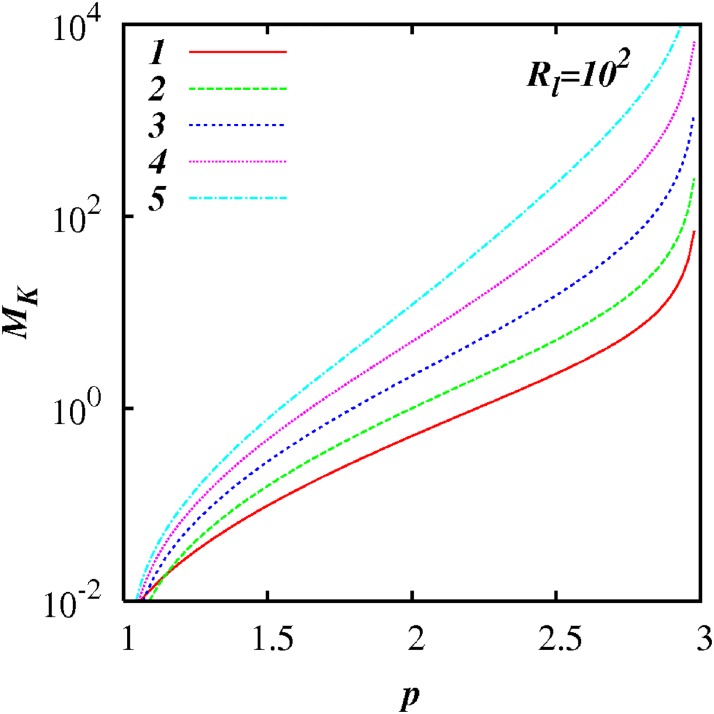
Similar to Fig 3, except for Rl = 102.